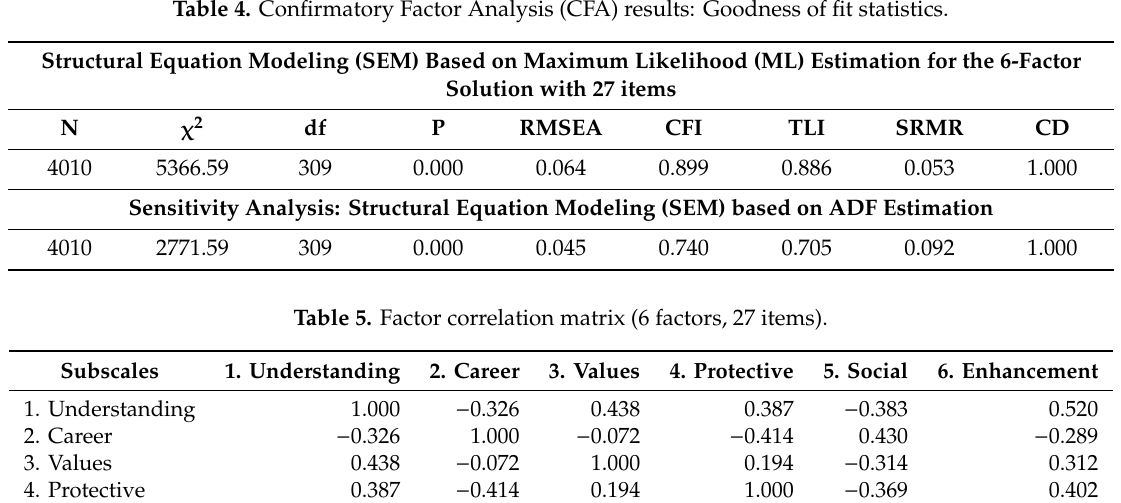
Table 4. Confirmatory Factor Analysis (CFA) results: Goodness of fit statistics.